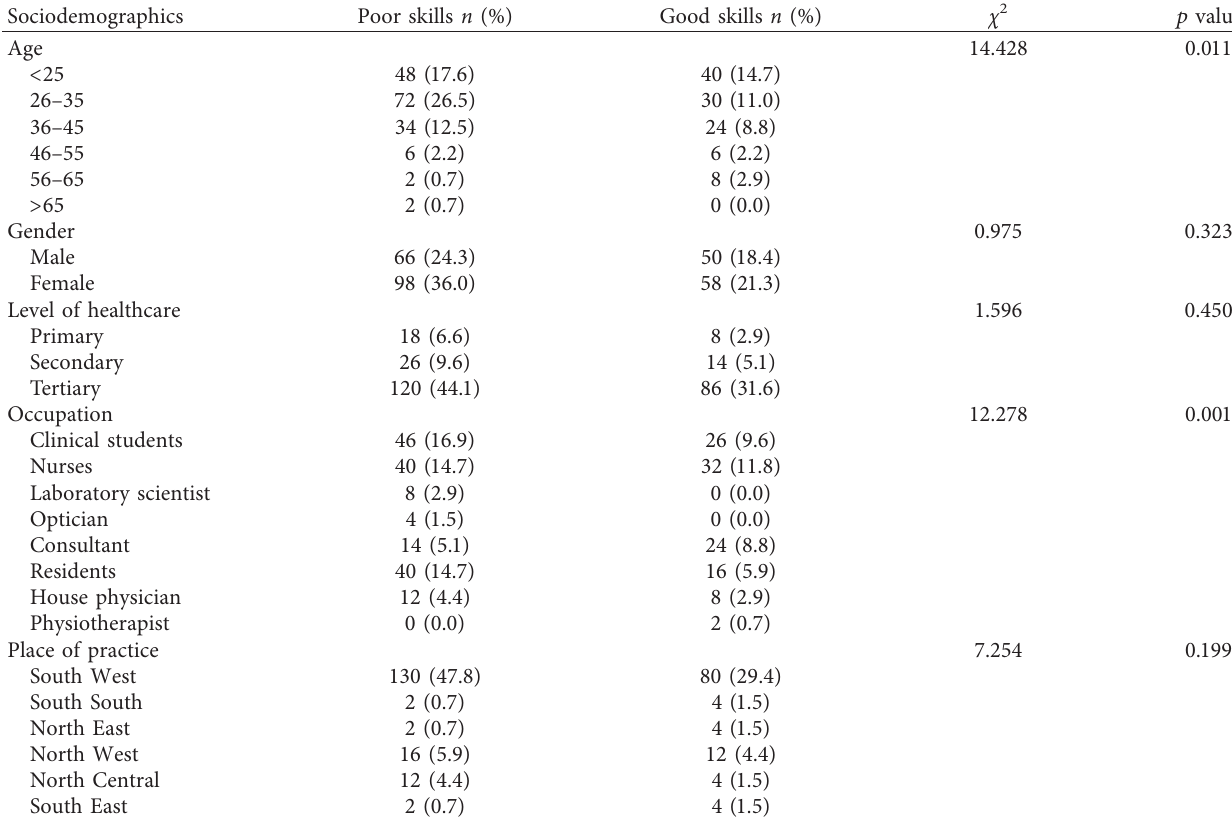
Table 7: Association between sociodemographic characteristics and healthcare workers’ PPE skills.